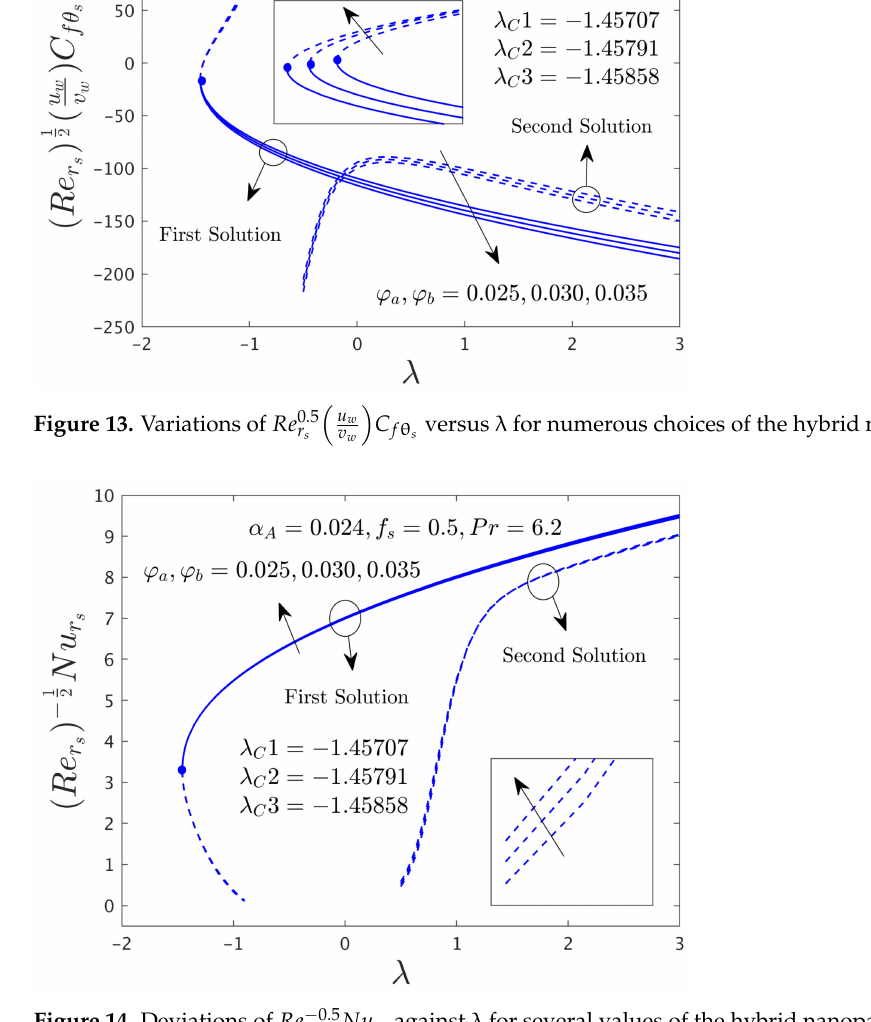
Nu r Figure 14. Deviations of Re − 0.5 r against λ for several values of the hybrid nanoparticles. s s Table 3. Computational data of the SFCs along the radial and azimuthal directions for the several values of the selected parameters when λ = –0.75 and Pr =